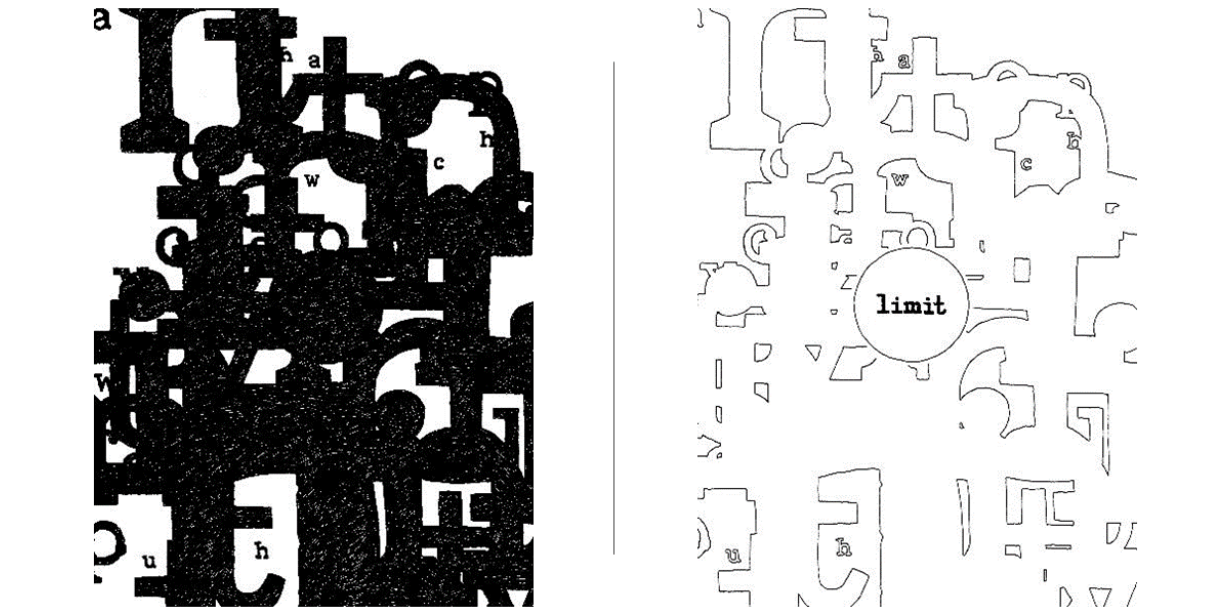
Figure 3. From Cotter, Nod Away , 13. Figure 4. From Cotter, Nod Away ,